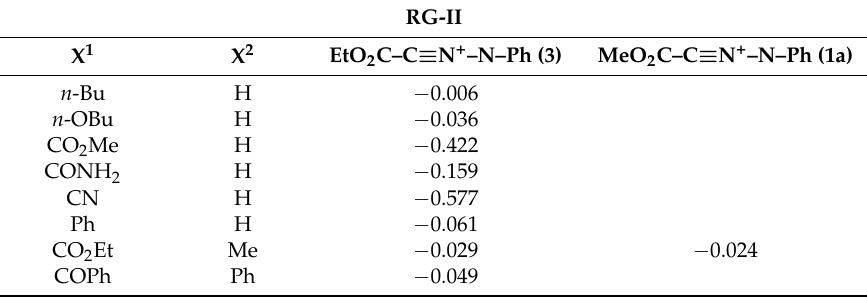
Table 11. Grand potential stabilization difference δ ∆Ω = ∆Ω (5-X 1 ) − ∆Ω (4-X 1 ) (meV) for 1,3-DC of nitrilimines 3 and 1a to alkenes. Negative values indicate that the 5-X-pyrazoline regioisomer is